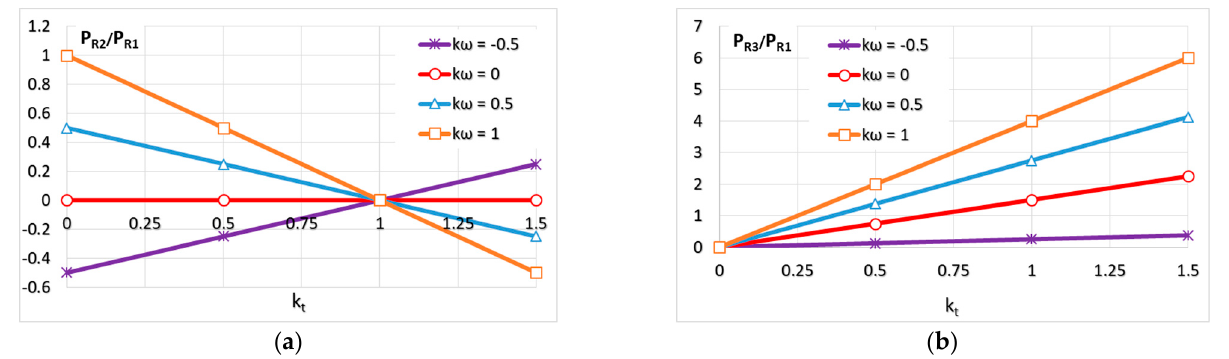
k for various values of ratio t